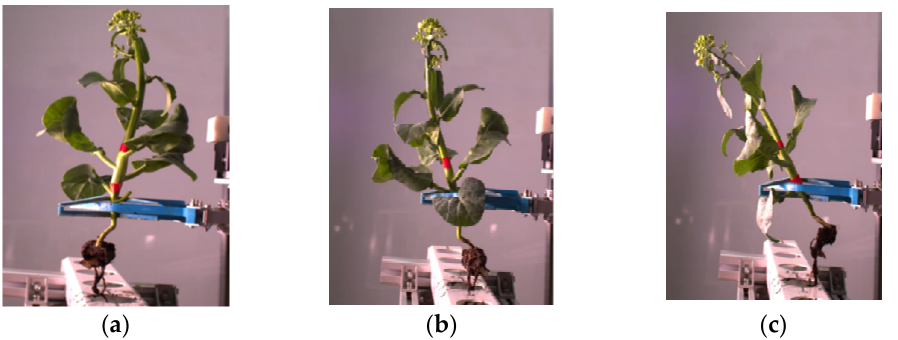
Figure 14. Successful grabbing attempts in the test: ( a ) the hydroponic Chinese kale was grabbed out of the cultivation pipeline in a fully vertical posture, ( b ) the hydroponic Chinese kale was grabbed out of the cultivation pipeline in a slightly inclined posture, and ( c ) the hydroponic Chinese kale was grabbed out of the cultivation pipeline in a relatively inclined posture.